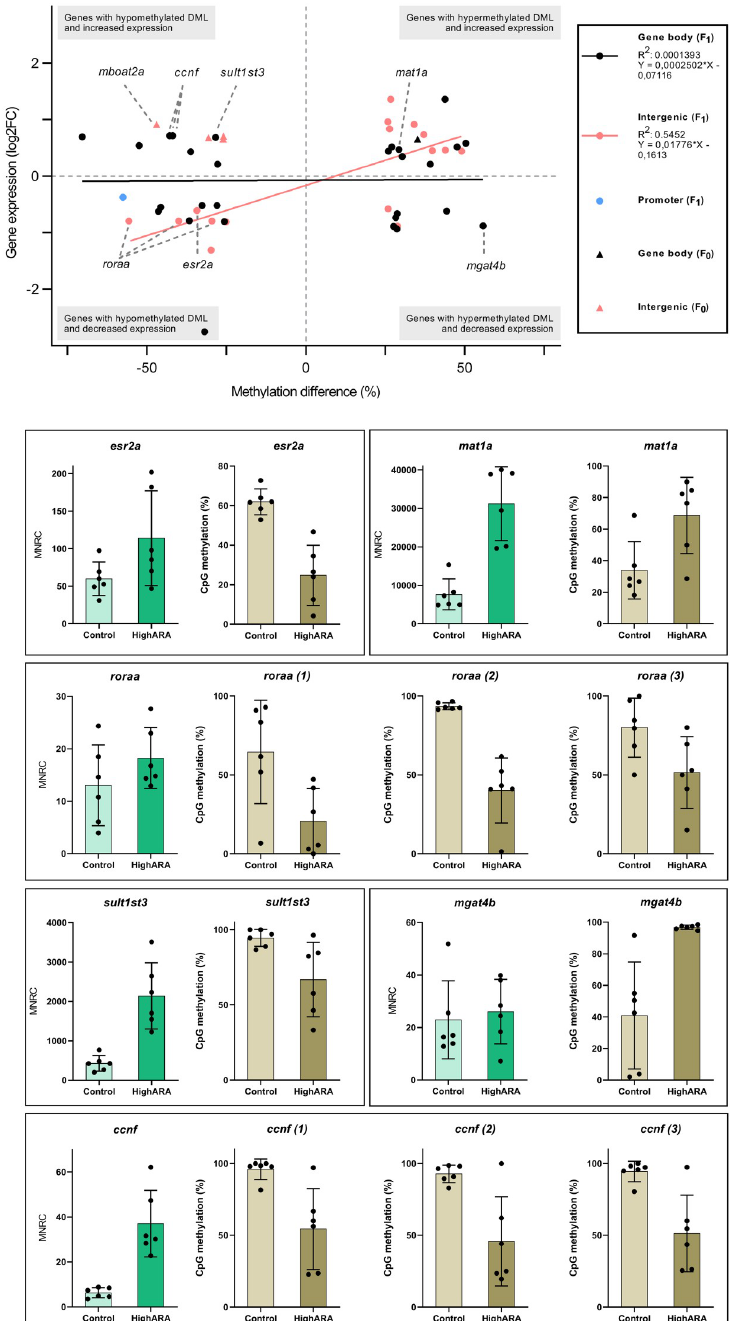
Fig 4. Genes associated with differential methylated loci (DML) and differential expression in F 0 and F 1 livers. A: Plot showing genomic locus-specific methylation differences and gene expression of concordant genes in F 0 (5) and F 1 (37) livers. Differentially expressed genes (adjusted p < 0.05 for F 1 and p < 0.1 for F 0 ) and DML (methylation difference +/- � 25% and q-value � 0.01) were obtained from F 0 and F 1 livers comparing high ARA and control group. Some of the genes in F 1 were annotated to more than one DML, which led to 46 comparisons in total (S8 File). A best fit line with equation and goodness of fit (R 2 ) quantified by linear regression (S8 File) is shown for F 1 DML located in gene bodies and intergenic regions. B: Bar graphs showing individual read counts and individual CpG methylation levels of single genes tagged in Fig 4A for each replicate of the high ARA and control group. Gene expression is shown as mean normalized read counts (MNRC) in high ARA versus control livers. CpG methylation was calculated as the percentage of total methylated CpGs over the total number of CpGs assessed.